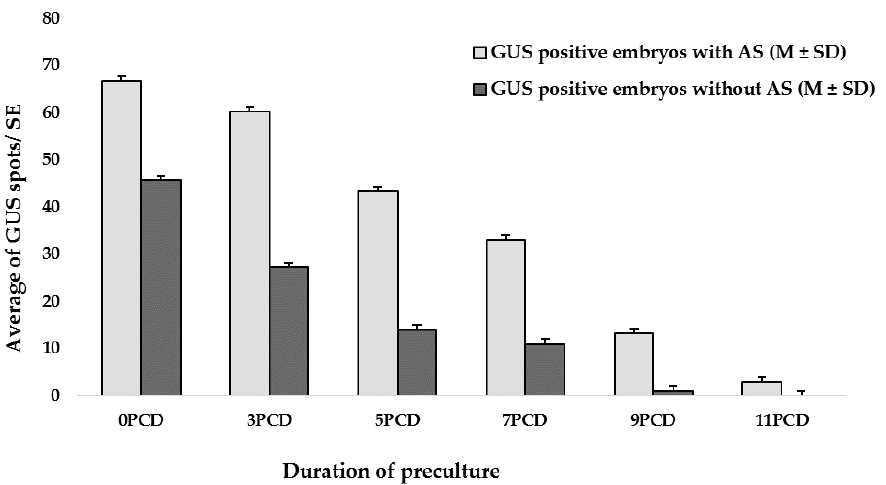
Figure 1. Effect of acetosyringone (AS) and preculture period (0, 3, 5, 7, 9, or 11 preculture days (PCDs)) on the average number of GUS spots per inoculated SE. Number of GUS spots per SE was recorded 3.5 days after bacterial inoculation.